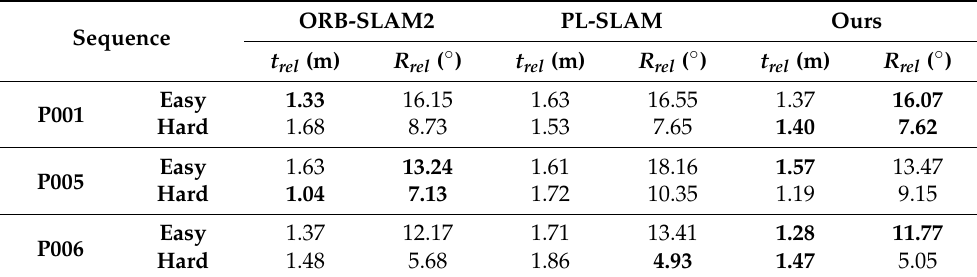
Table 2. Mean relative pose error (RPE) in the TartanAir dataset. Bold numbers represent the best